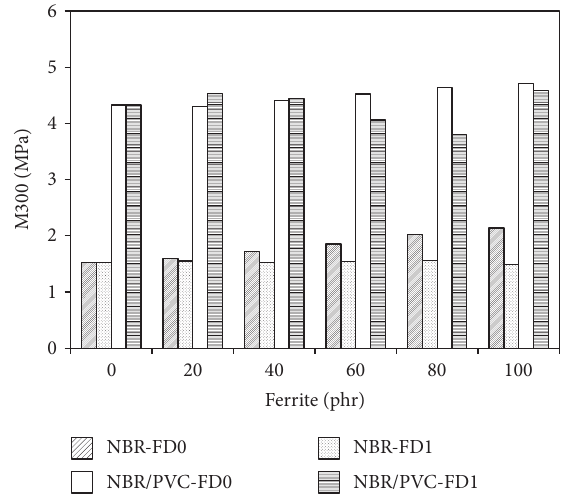
Figure 10: Influence of ferrites content on elongation at break of